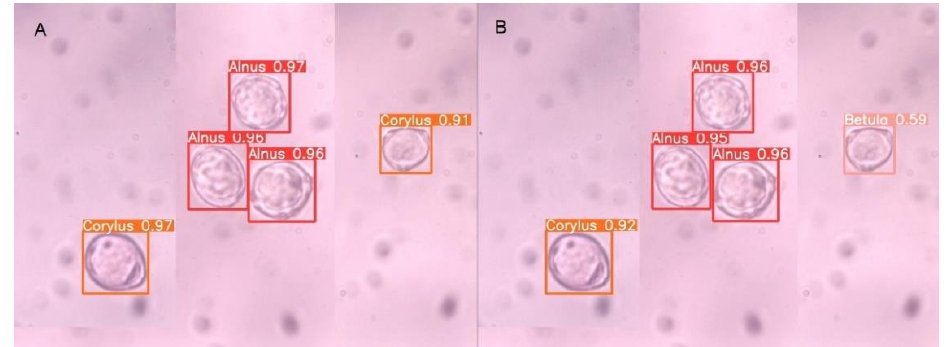
Figure 4. Sample image from the testMix dataset with predicted bounding boxes: ( A ) ModelAll (YOLOv5s) with Betula grains incorrectly detected as Corylus grain; ( B ) ModelVisAll (YOLOv5s) with a correctly detected Betula